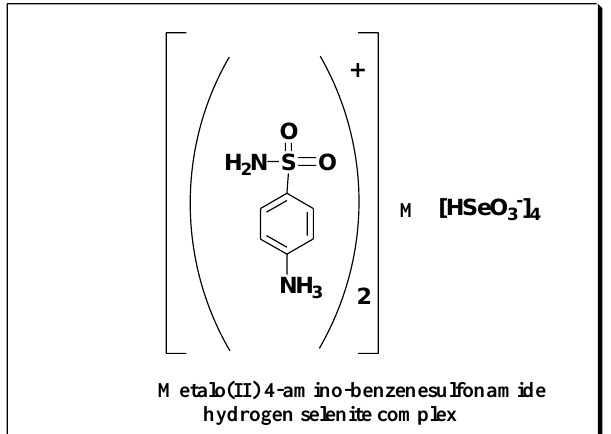
Figure 2. Metalo (II) 4-amino-benzenesulfonamide hydrogen complex .